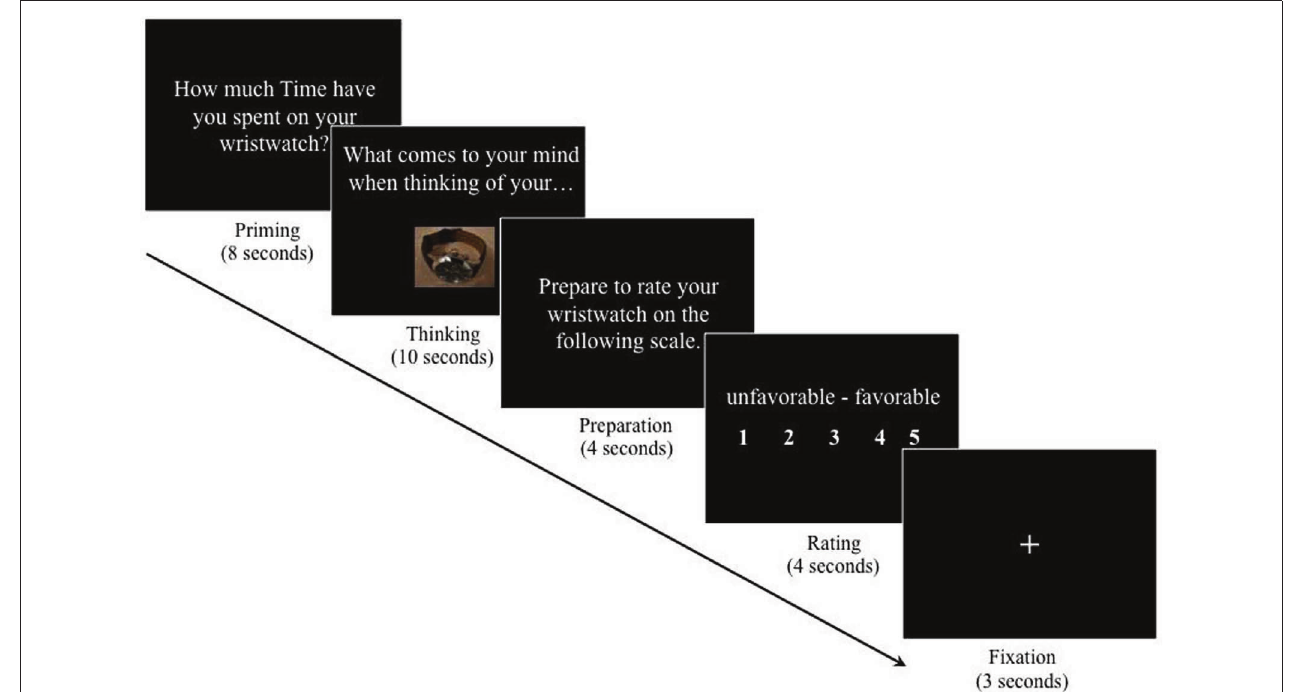
FIGURE 1 | Product-rating